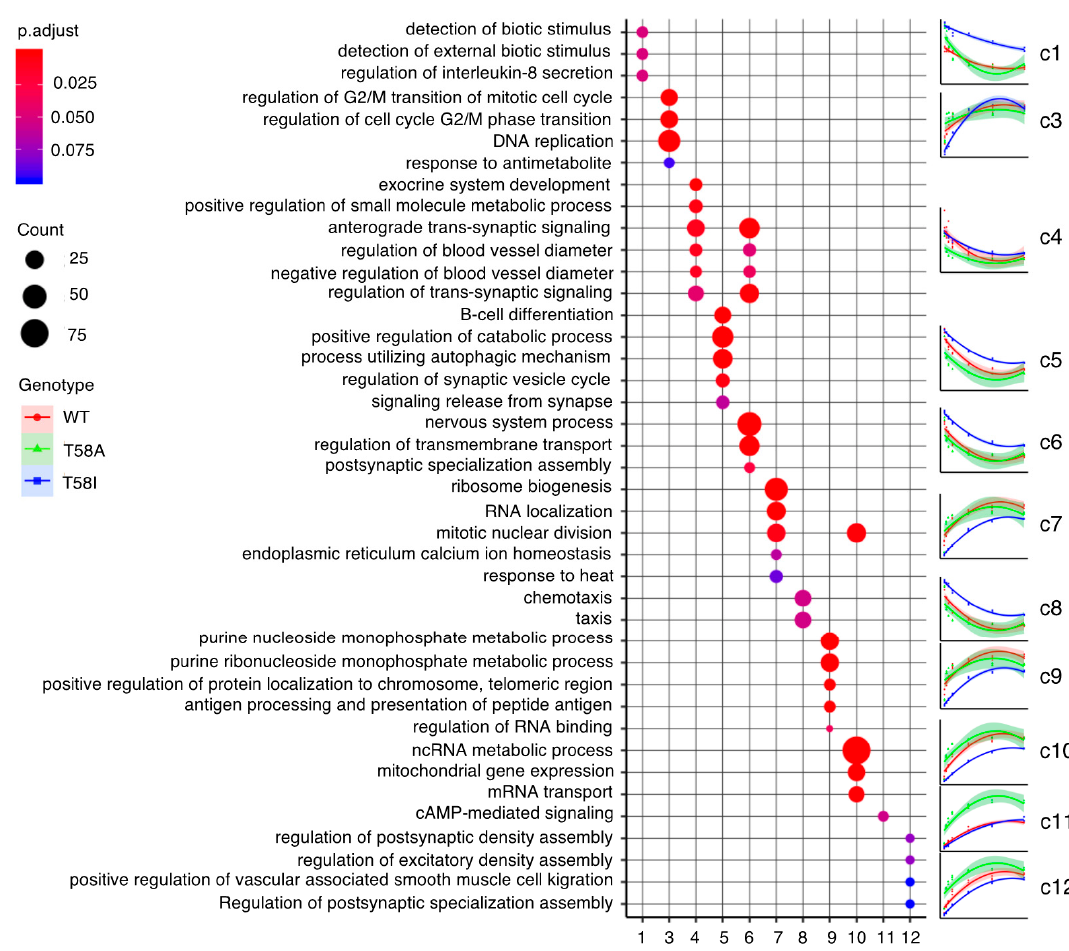
Figure 4. Gene ontology functional classification of clustered genes. Over-representation tests of clustered genes in gene sets with different gene ontology (GO) terms, representing biological processes, for clusters c1 and c3–c12. The most enriched gene sets following GO term simplification are shown. Median RPKM values for genes in denoted clusters are plotted (right panels) for MYC WT (red), MYC T58A (green) and MYC T58I (blue) for increasing doxycycline levels (0, 25, 50, 100, 300, 600 and 1000 ng/mL), and the colored lines corresponding to the respective MYC genotype represent a 2nd degree polynomial regression model where the shaded areas indicate the 95% confidence interval for the model (larger high resolution plots are available in Supplementary Figure S4).